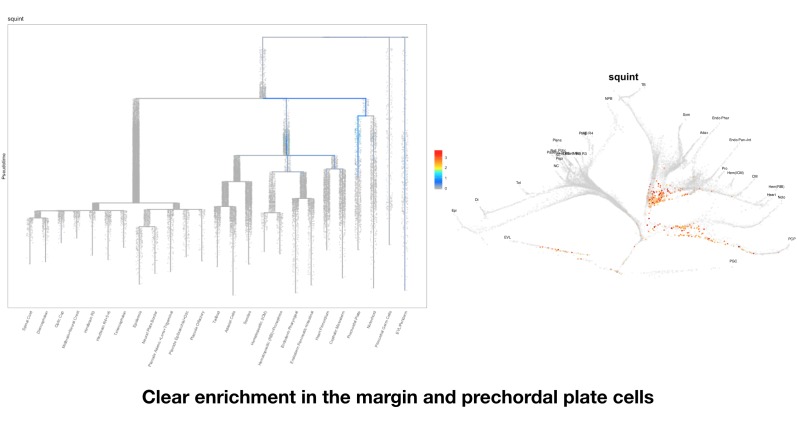
Clear enrichment in the margin and prechordal plate cells.